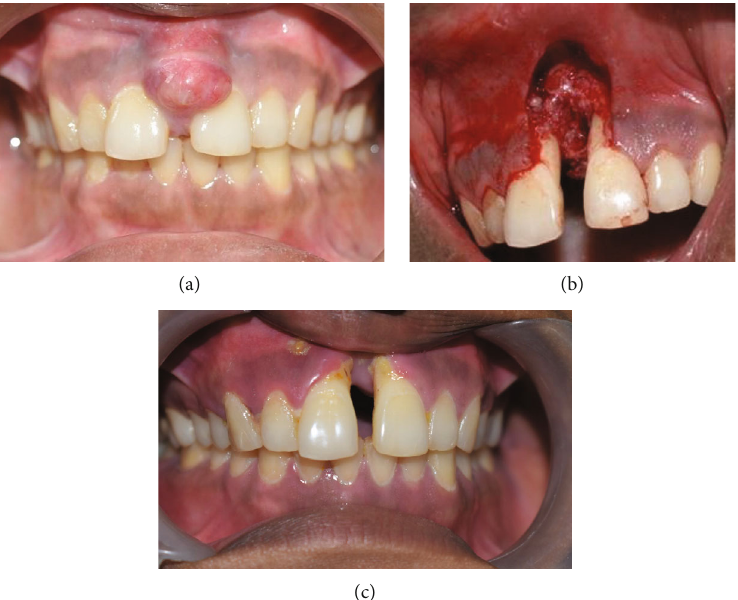
Figure 3: (a) Pre-operative view of growth. (b) Immediate post-operative view after excision of the lesion. (c) 3 months post-operative